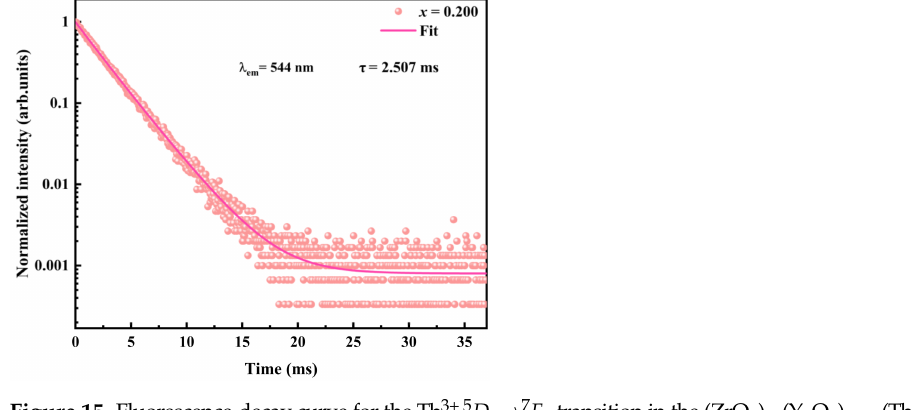
atmosphere; Figure S3: XPS Y 3 d core-energy-level spectrum of (ZrO 2 ) 92 (Y 2 O 3 ) 7.800 (Tb 4 O 7 ) 0.200 single-crystals before and after annealing at 1500 ◦ C in a H 2 /Ar